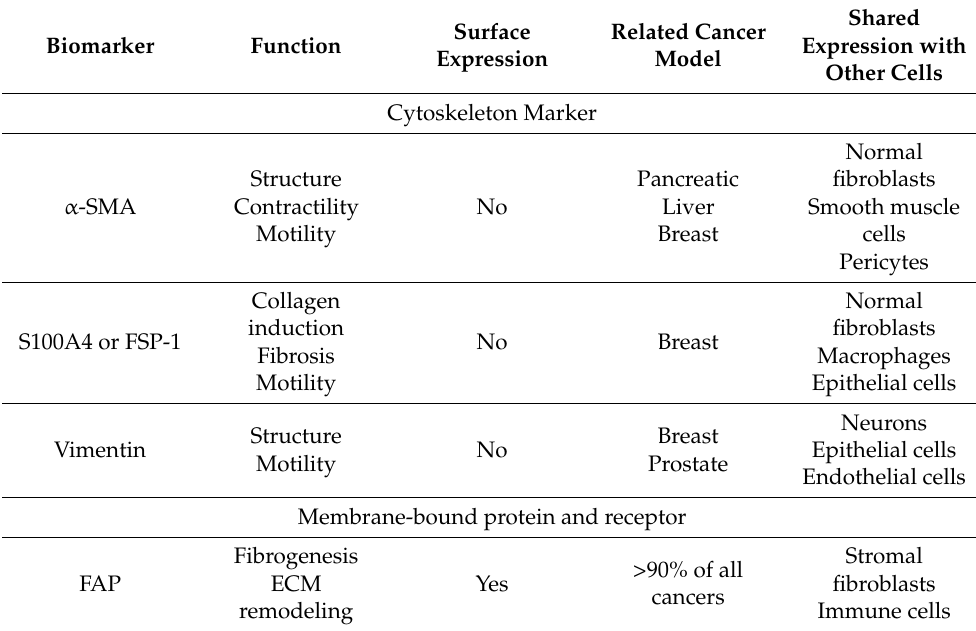
Table 1. Typical biomarker expression in CAFs and their biological